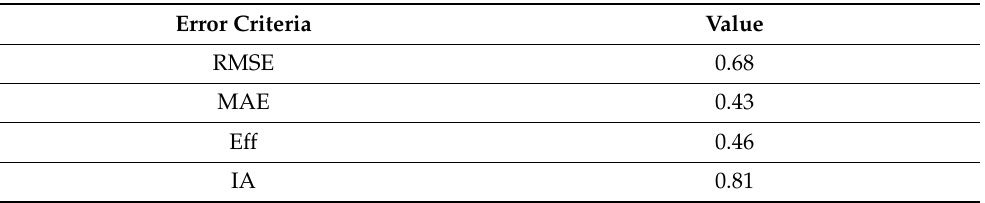
Table 7. Error criteria for the GALDIT-I method.